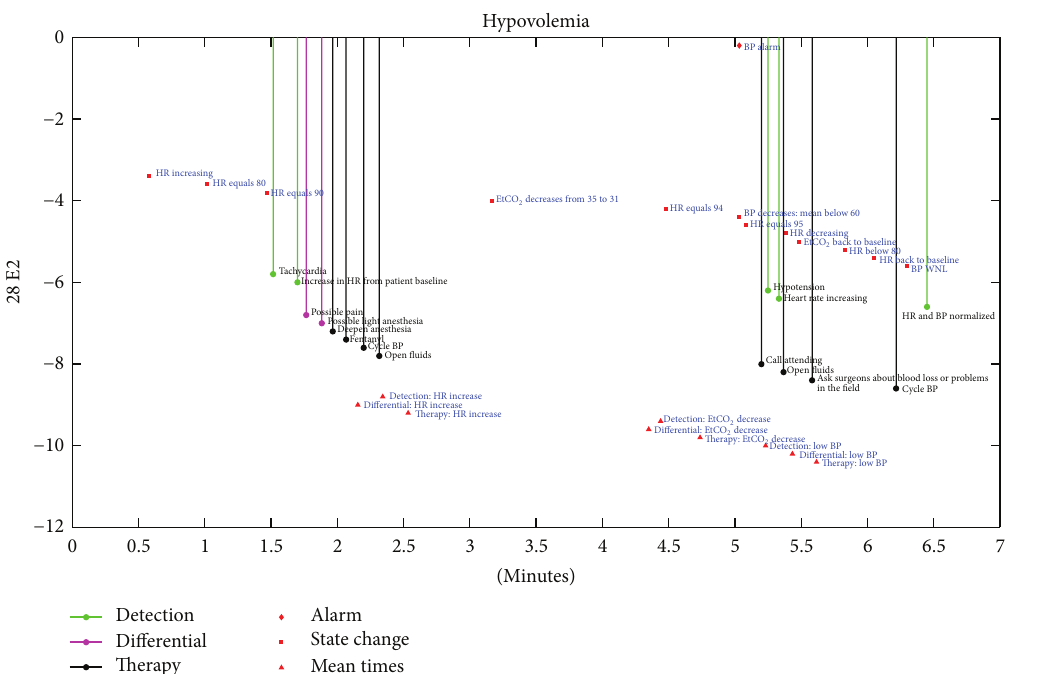
Figure 4: Stem plot showing the responses entered by a subject into the GUI during the “hypovolemia” scenario. Note that the 𝑦 -axis scale does not have any informative value. The diamond and square red markers represent the times when state changes and alarm annunciation occur in the script. The filled circles are color coded based on the legend and show the relative times and text responses entered by subjects. The red triangles represent the average times subjects took to detect, diagnose, and treat scripted